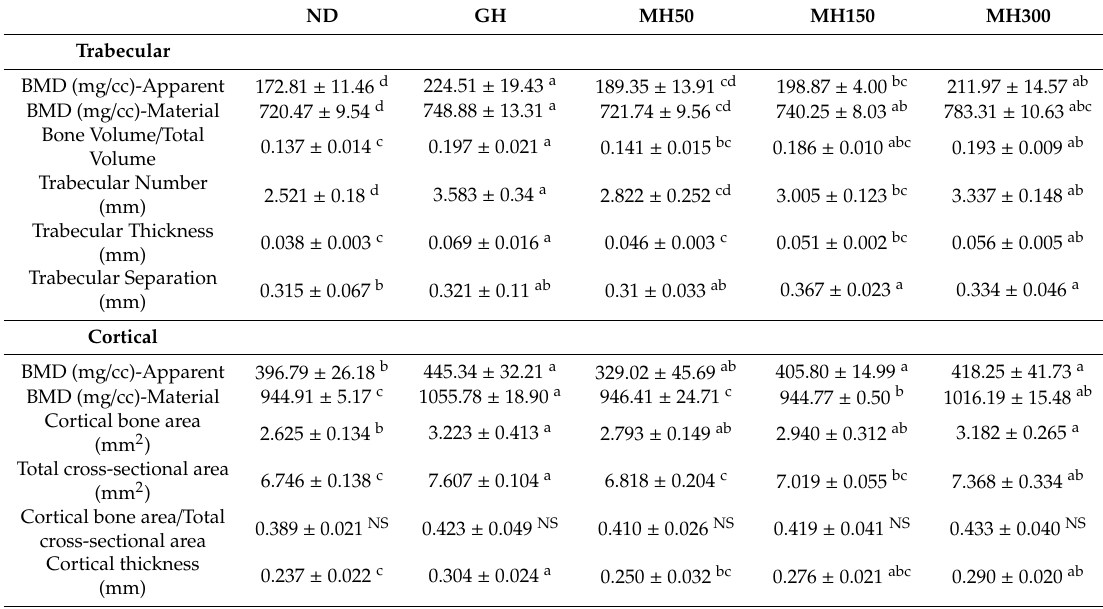
Figure 2. The effect of dietary administration of a mixture of H. japonicus (MH) on architectural changes of tibia trabecular and cortical in SD rats. ND (normal diet control): AIN93M diet; GH: AIN93M diet + intraperitoneal injection of 0.37 mg/kg b.w./day recombinant growth hormone; MH50: Table 2. The e ff ect of dietary administration of a mixture of H. japonicus (MH) on trabecular and cortical mineralization parameters in SD